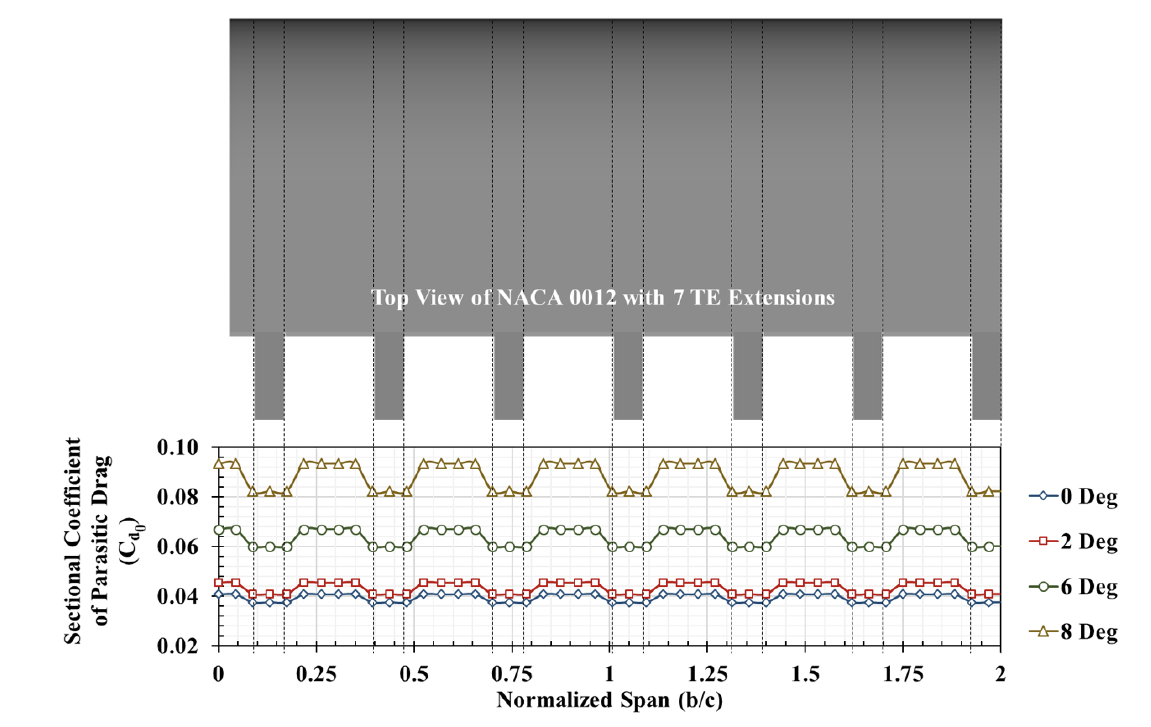
Figure 13. Section drag coefficient variation across the span for wing with seven TE extensions. The drag coefficient behind the TE extension is lower than the drag coefficient behind the trailing edge of NACA